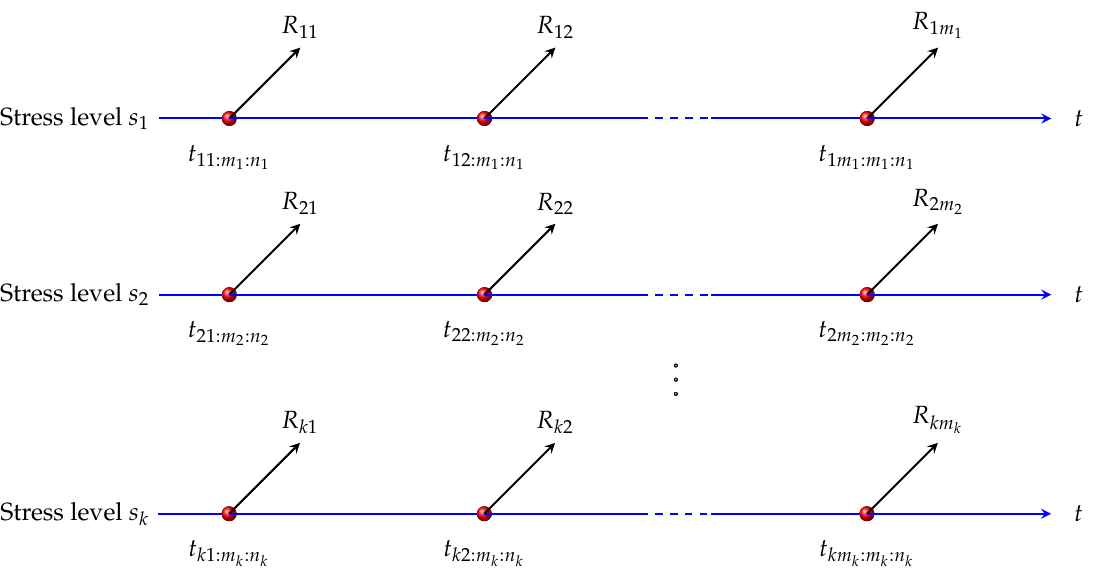
(cid:0) (cid:1) R i 1 , R i 2 , · · · , R im at stress i